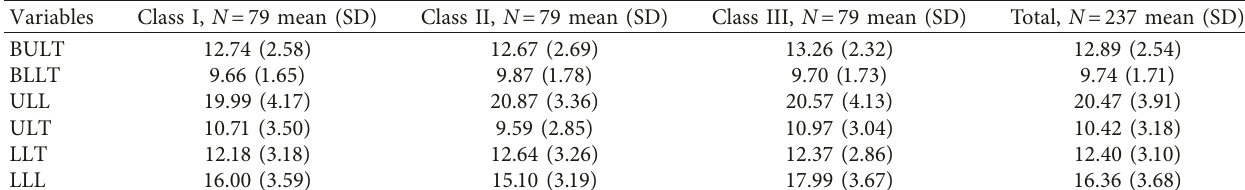
Table 1: Descriptive statistics of different variables among different skeletal malocclusion groups.